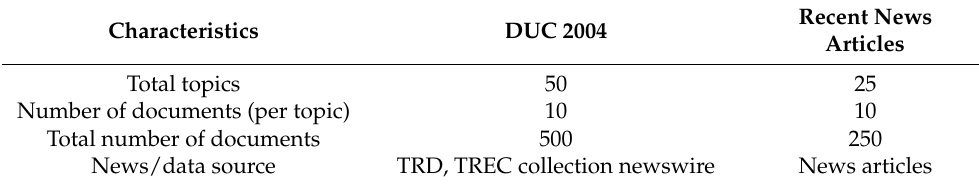
Table 1. Characteristics of datasets at a